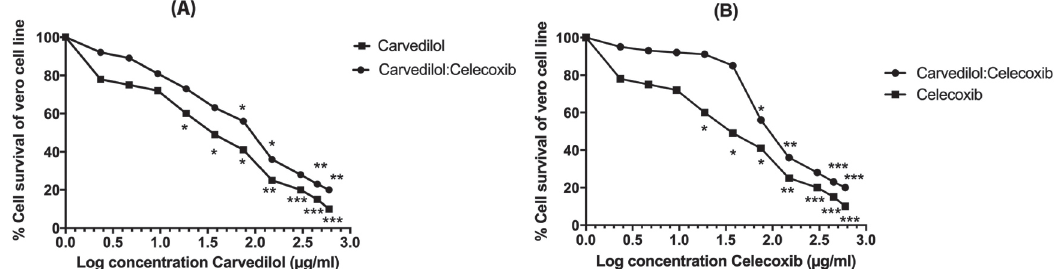
FIGURE 1 - Concentration dependent response in cell survival percentage (CSP) of Vero cells (2 x 104 cells/0.1 mL/well) assessed by MTT assay after 48 hours of incubation with test chemicals, (A) comparison of CSP after carvedilol and combine concentration of carvedilol and celecoxib (B) comparison of CSP after celecoxib and combine concentration of carvedilol and celecoxib. The graph shows that anti-proliferative effect of combine concentration carvedilol:celecoxib) was significant at lower level as compare to both carvedilol and celecoxib alone. Each value represent of mean three replicates (n=3). The asterisks indicate significant difference at three levels (*p<0.05, **p<0.01, ***p<0.001) between cells cultured after 48 hours of